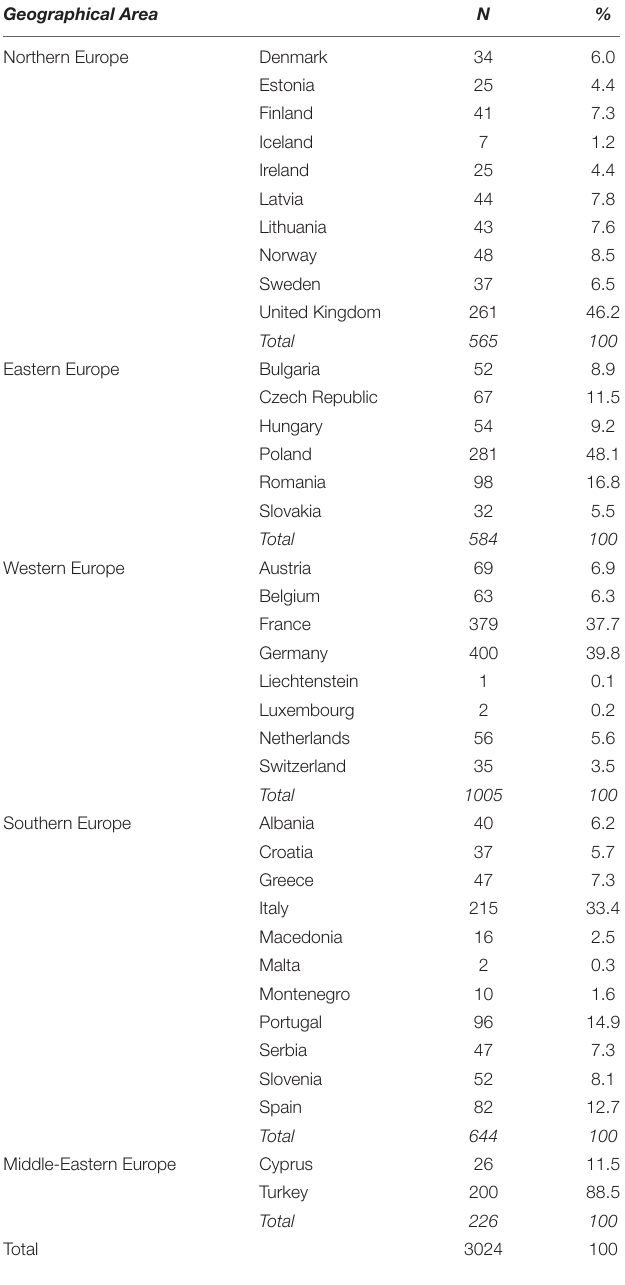
TABLE 1 | Descriptive statistics of the institutions mapped in each country for every geographical area. Geographical Area N % Northern